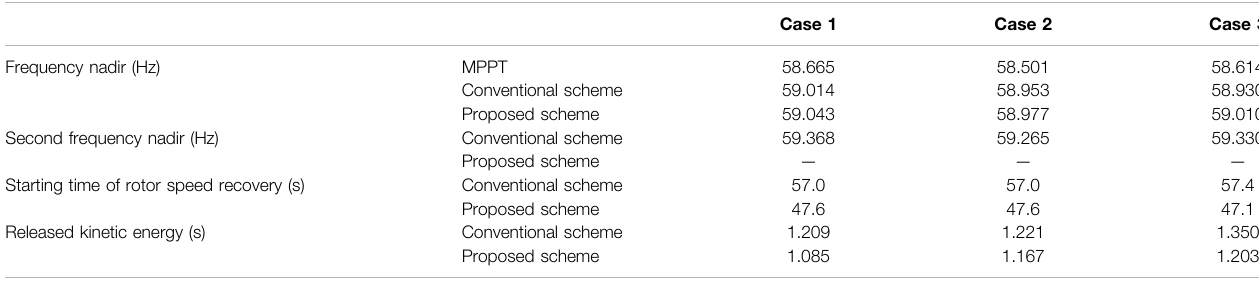
TABLE 2 | Simulation results for all cases.